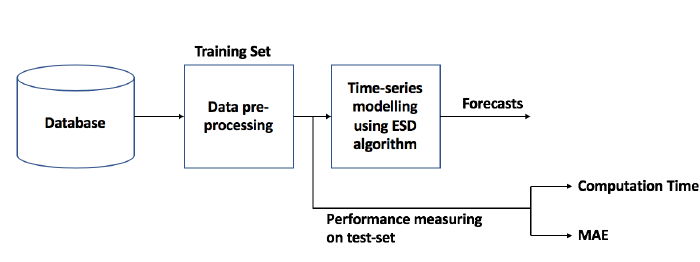
Figure 7. ESD modeling and forecasting